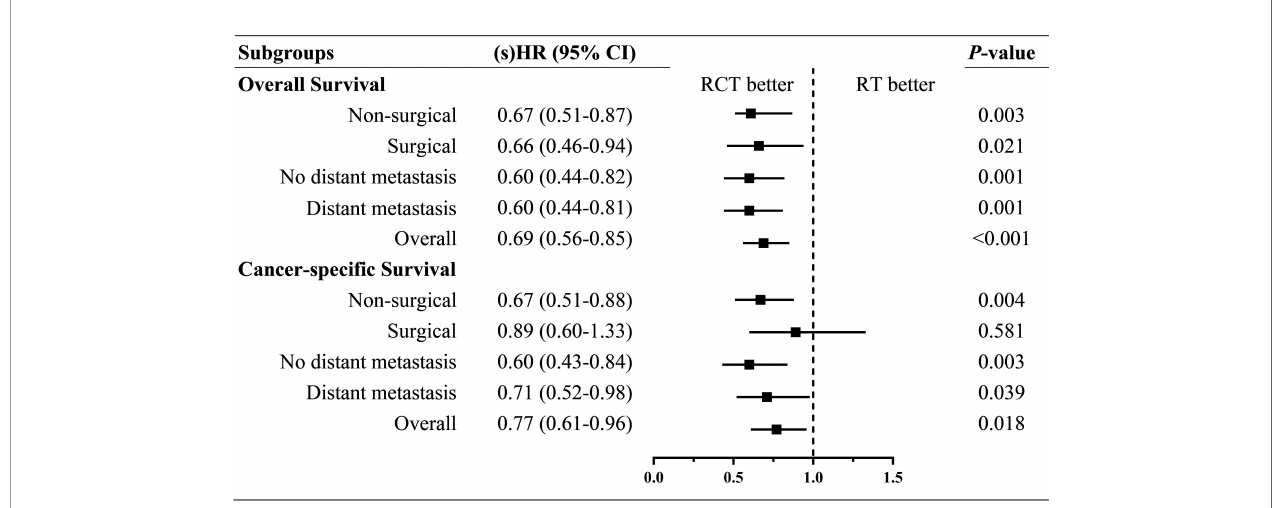
FIGURE 3 | Forest plot of (sub distribution) hazard ratios of RCT versus RT within each subgroup by surgical resection and distant metastasis. sHR, subdistribution hazard ratio; HR, hazard